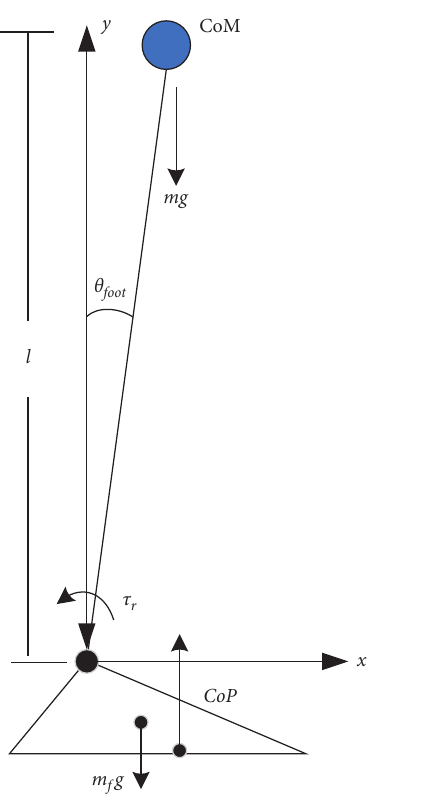
Figure 2: The bipedal robotic inverted pendulum model.